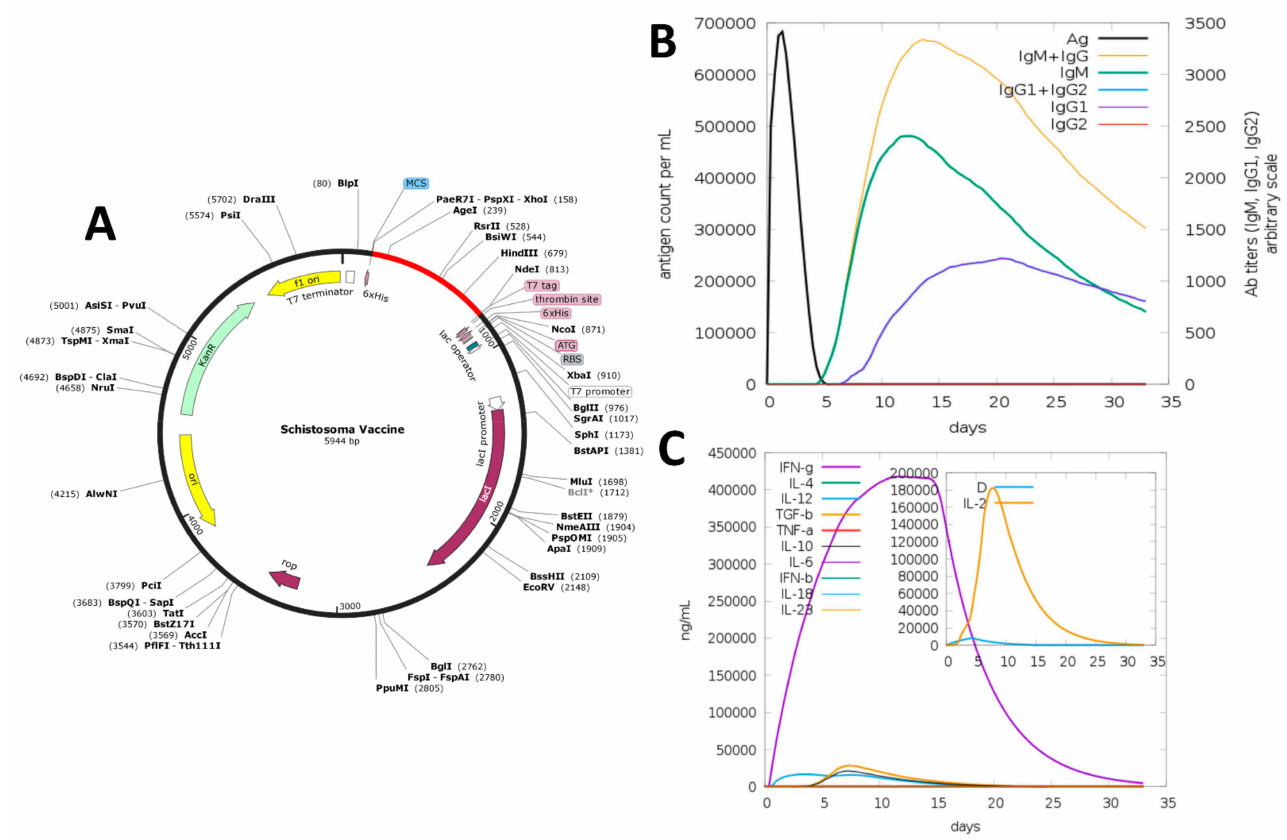
Figure 2. In silico cloning and immune simulation studies of the MEV: ( A ) cloned sequence of the MEV (colored as red) in the pET28a (+) expression vector; ( B ) immunoglobulins response per mL to the presence of the MEV antigen; ( C ) interferon and interleukins concentration in ng/mL generated in response to